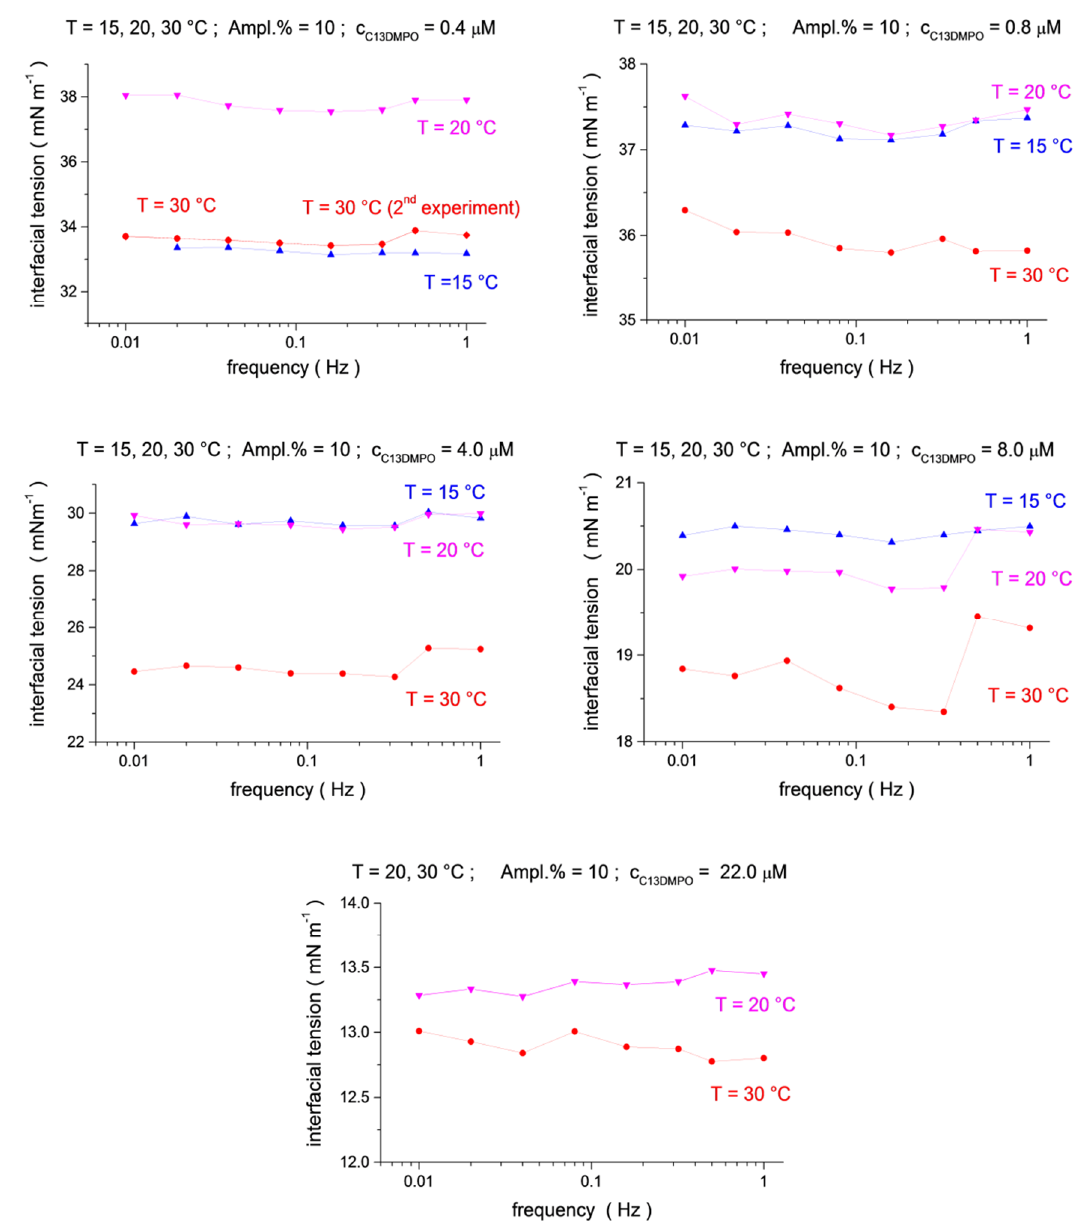
Figure 1. Temperature dependence (blue up triangles T = 15 ◦ C, magenta down triangles T = 20 ◦ C, red circles T = 30 ◦ C) for the mean-level values of interfacial tension oscillations as a function of frequency (f = 0.01, 0.02, 0.04, 0.08, 0.16, 0.32, 0.5 and 1.0 Hz) at C 13 DMPO concentrations of c 1 = 4.0 × 10 − 7 , 8.0 × 10 − 7 , 4.0 × 10 − 6 , 8.0 × 10 − 6 and 2.2 × 10 − 5 mol / dm 3 , and at a fixed TTAB concentration c 2 = 4.5 × 10 − 5 mol / dm 3 .